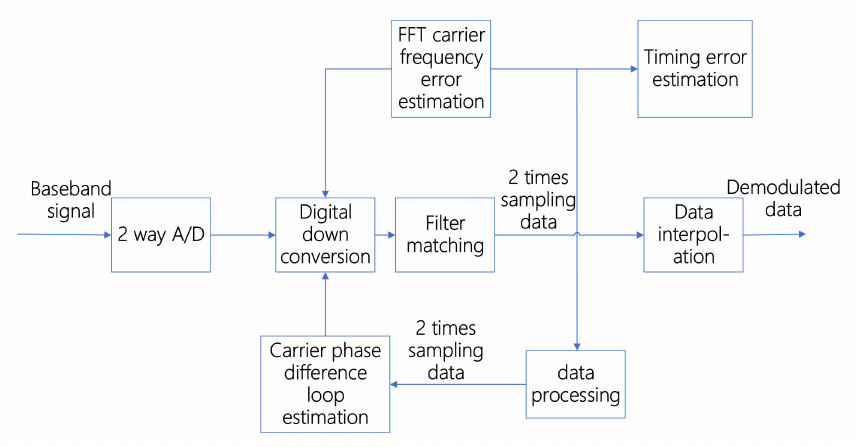
Figure 3. Schematic